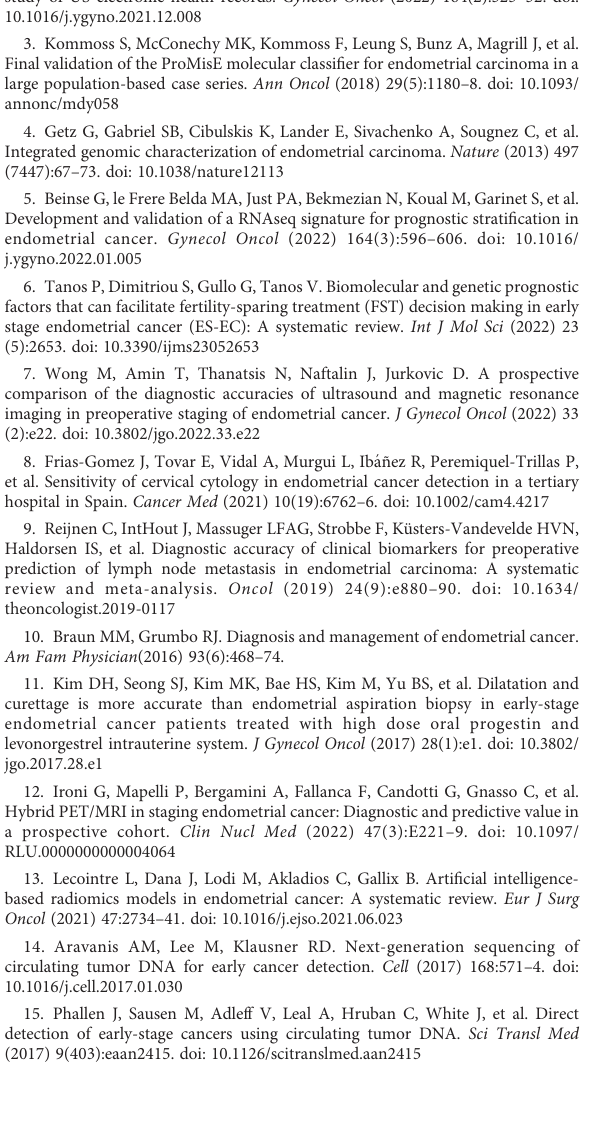
SUPPLEMENTARY FIGURE 1 Representative IHC picture from a patient with MSH6 loss of expression and MSH6 mutation based on cervical swab-based gDNA (EMC_051).